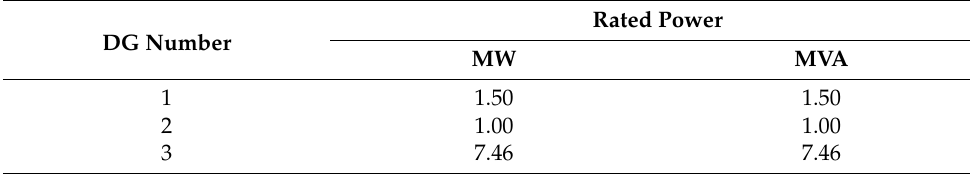
Table 2. Rated power of photovoltaic power